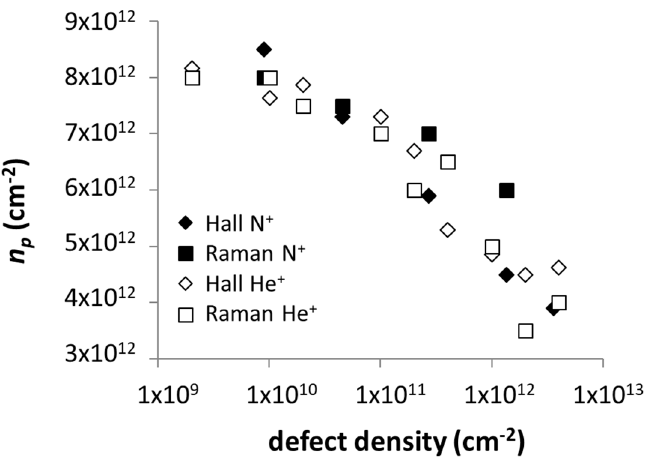
Figure 5. Hole concentration n p versus defect density obtained from Hall (diamonds) and from Raman measurements (squares) after nitrogen (solid points) and helium (open points) ion implantation.